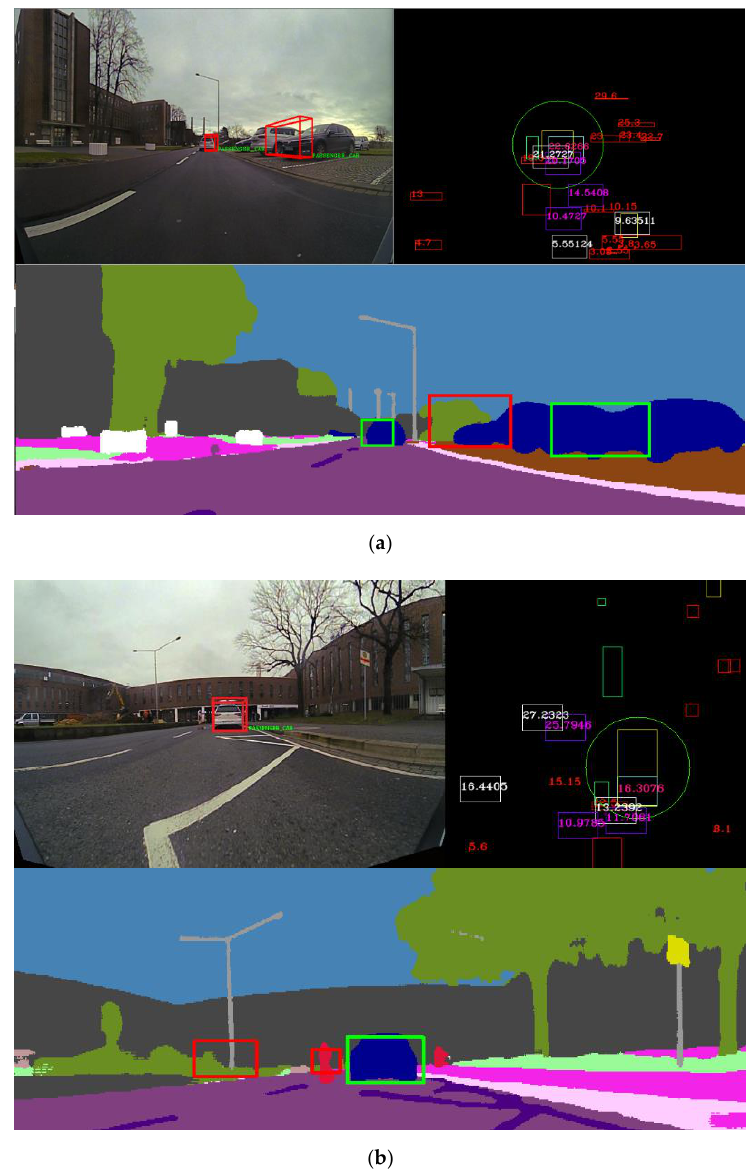
Figure 24. ( a ) In the top-right image, we observe the birds-eye view virtual scene of the real-world scenario, where all objects are projected. We note the presence of multiple super-sensor objects. In the bottom figure, the fused objects are projected onto the semantic segmentation image, and if the object is validated, a green rectangle is drawn; otherwise, the rectangle drawn has red color. In the top-left image, only the validated super-sensor objects are projected onto the RGB image. ( b ) Another scene where we note the presence of multiple super-sensor objects. In the top right, the birds-eye view image is depicted. The bottom image shows the semantic image with the validated super-sensor objects drawn in green and objects that are not validated drawn in red. The top-left image illustrates the RGB image, where the super-sensor objects are displayed.